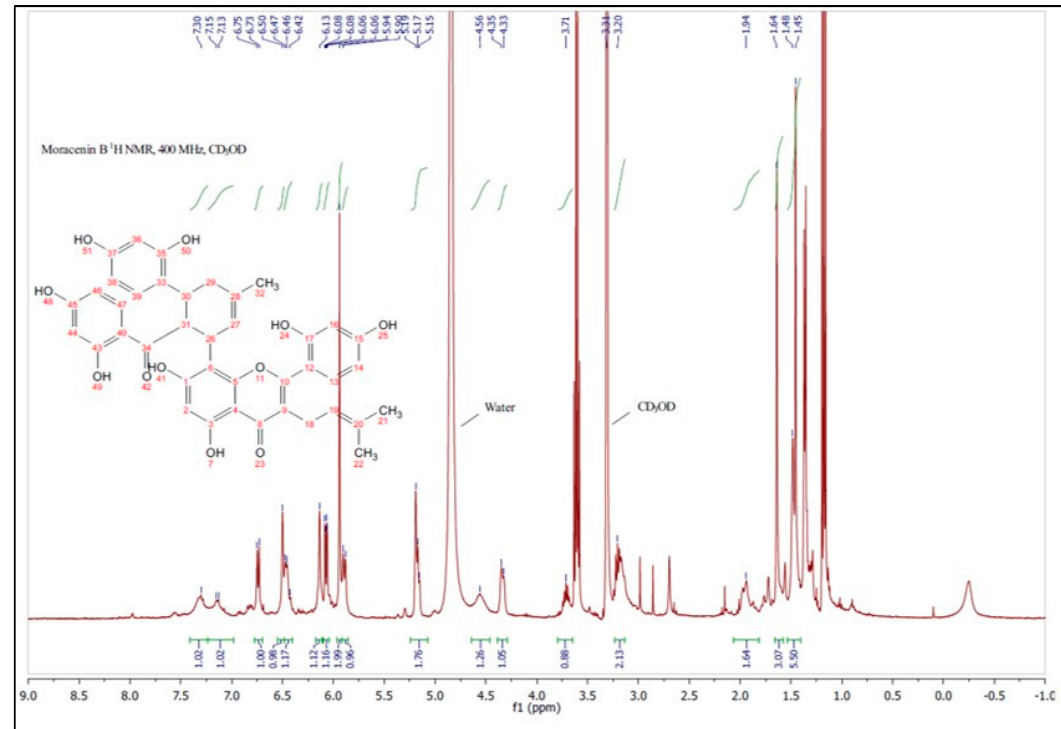
Figure A2. 1 H-NMR (400 MHz, CD 3 OD) spectrum of the compound Moracenin B.